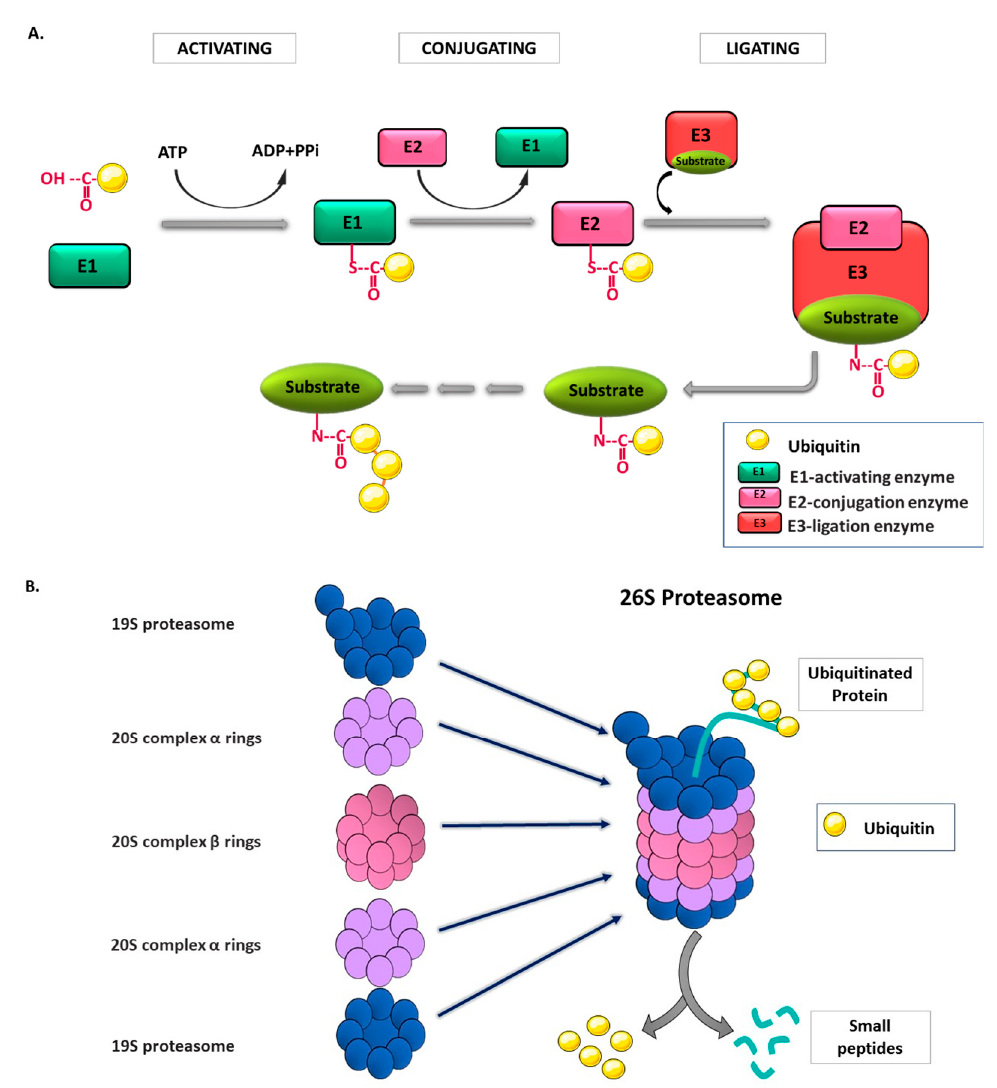
Figure 2. Ubiquitin proteasome system (UPS). ( A ) Enzymatic reaction of ubiquitination. For activation of the ubiquitination process, the E1 enzyme makes a thioester bond with the ubiquitin molecule, and the required energy is supplied by the hydrolysis of ATP. In the conjugation step, the ubiquitin on the E1 enzyme is transferred to the E2 enzyme. Finally, the substrate–E3 enzyme bond is involved, and the C-terminal of the ubiquitin molecule makes a covalent bond with the substrate, which is bound to the E3 enzyme. ( B ) Structure of proteasome and degradation of ubiquitinated substrates. The 26S proteasome has a multicomplex structure that is composed of a 19S regulatory units and a 20S catalytic core unit. In the 19S regulatory complex, the ubiquitinated proteins are unfolded, and ubiquitin tags are separated from the protein by deubiquitinase enzymes. Consequently, the unfolded polypeptide chain is delivered to the 20S catalytic core complex where they are degraded into small peptides.